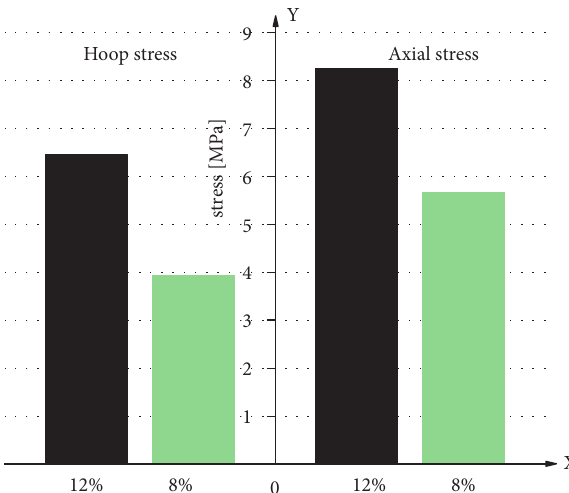
Figure 14: Stress of different expansive agents.